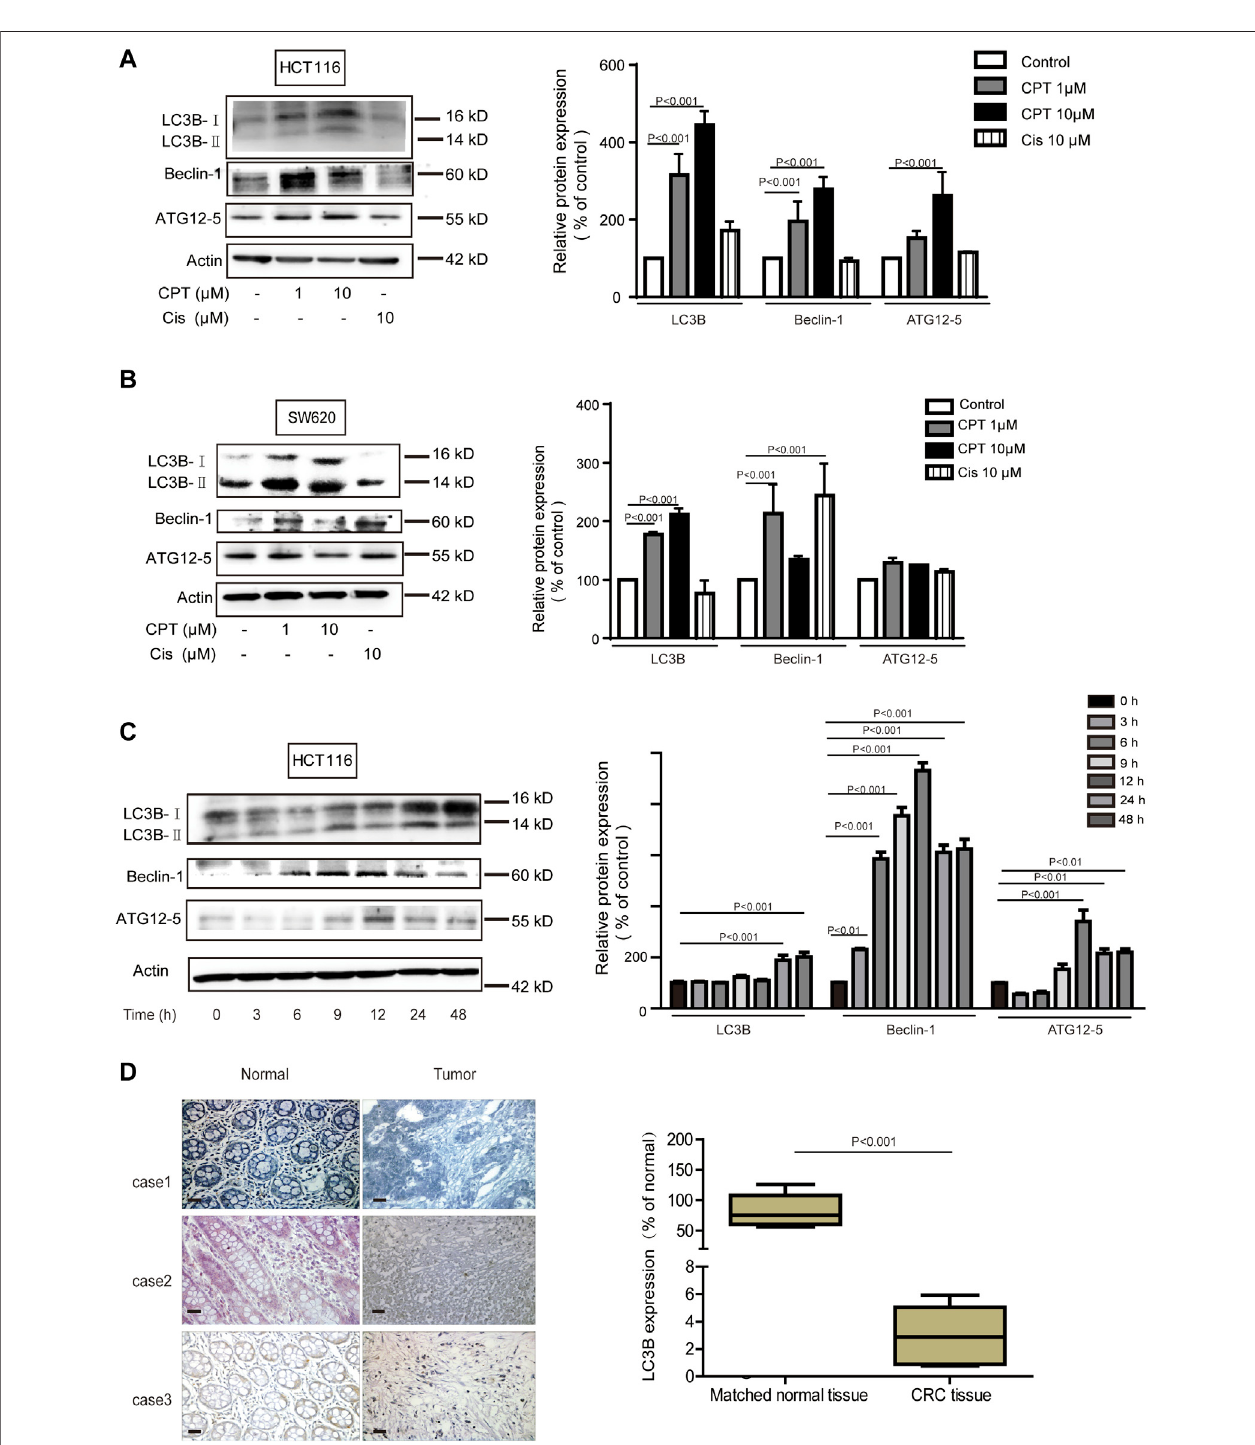
FIGURE 4 | In CRC cells, autophagy mediates the anti-tumor effect of CPT. LC3B, Beclin-1, and ATG12 – 5 of HCT116 cells (A) and SW620 cells (B) treated with different concentrations of CPT or Cis for 48 h was detected by immunoblotting and quantitatively analyzed by ImageJ. LC3B, Beclin-1, and ATG12 – 5 in HCT116 cells treated with CPT at a concentration of 10 μ M for different times was detected by western blot and quantitatively analyzed by Image J (C) . The immunohistochemical analysis of the clinical samples were performed, and the expression of LC3 was detected in the tumor tissue and the corresponding para-cancer tissue, and the quanti fi cation analysis was performed with Image J (D) . CPT, cryptotanshinone; CRC, colorectal cancer.